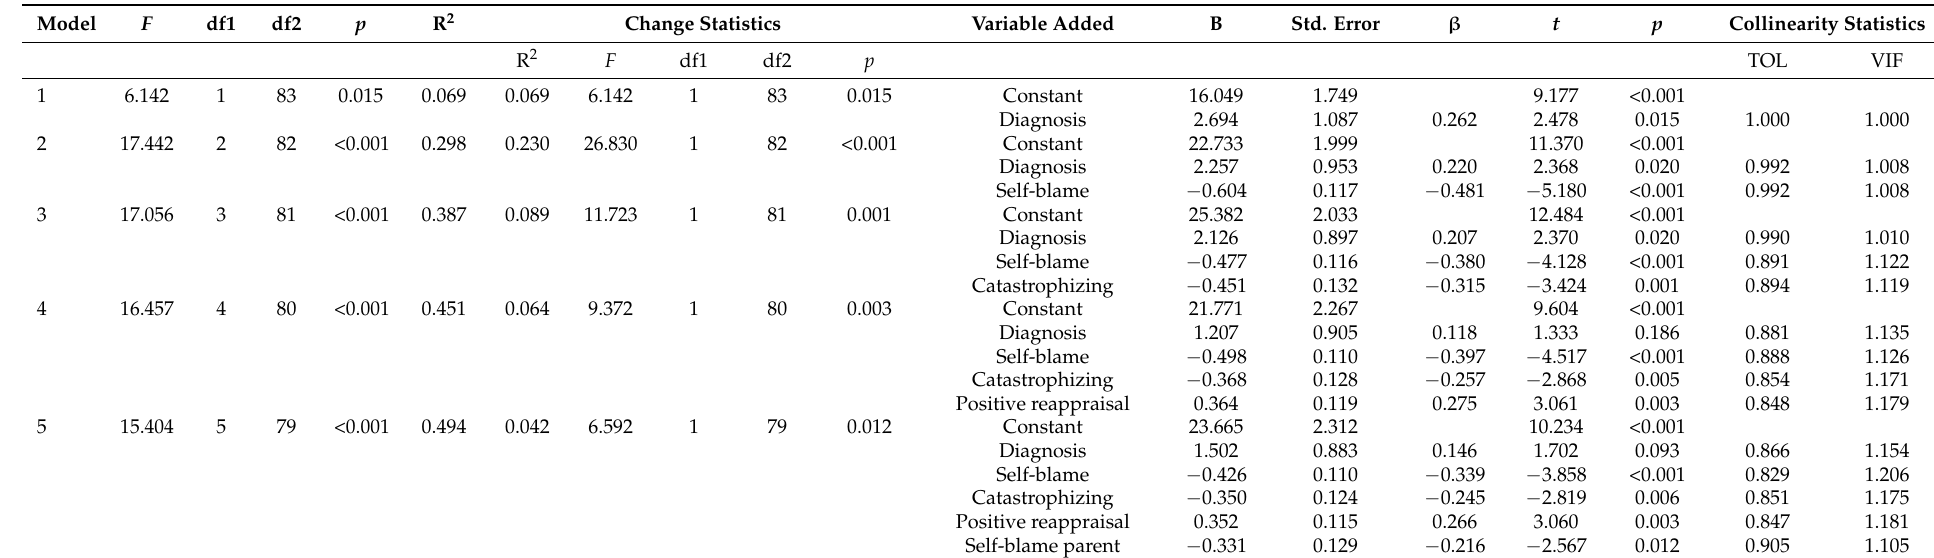
Table 4. Hierarchical Linear Regression Analysis with ILC as Dependent